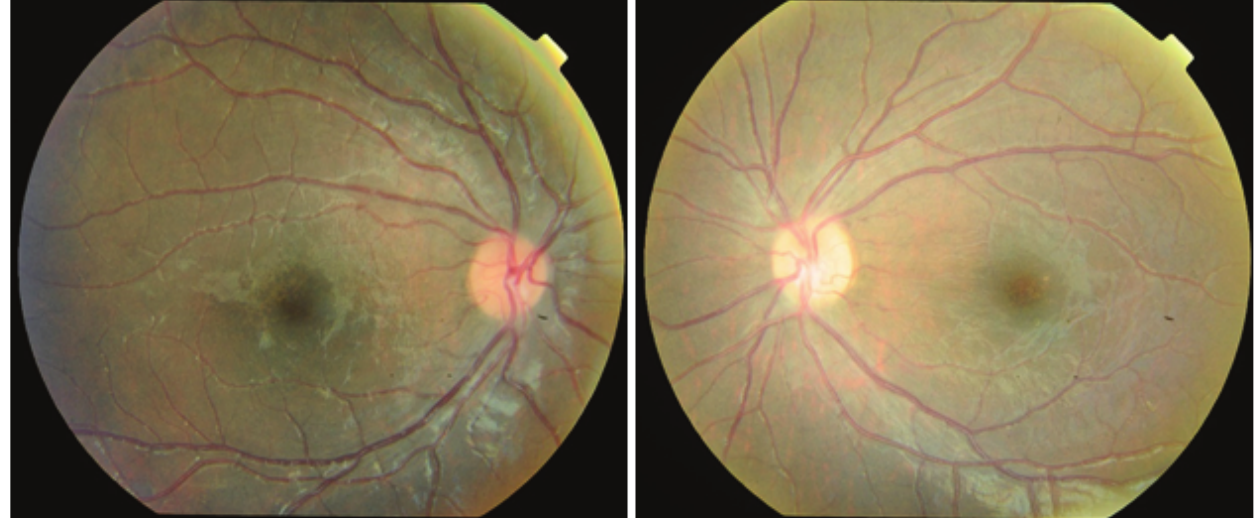
Figure 5. Fundus photography after 12 months of treatment shows mild granular macular